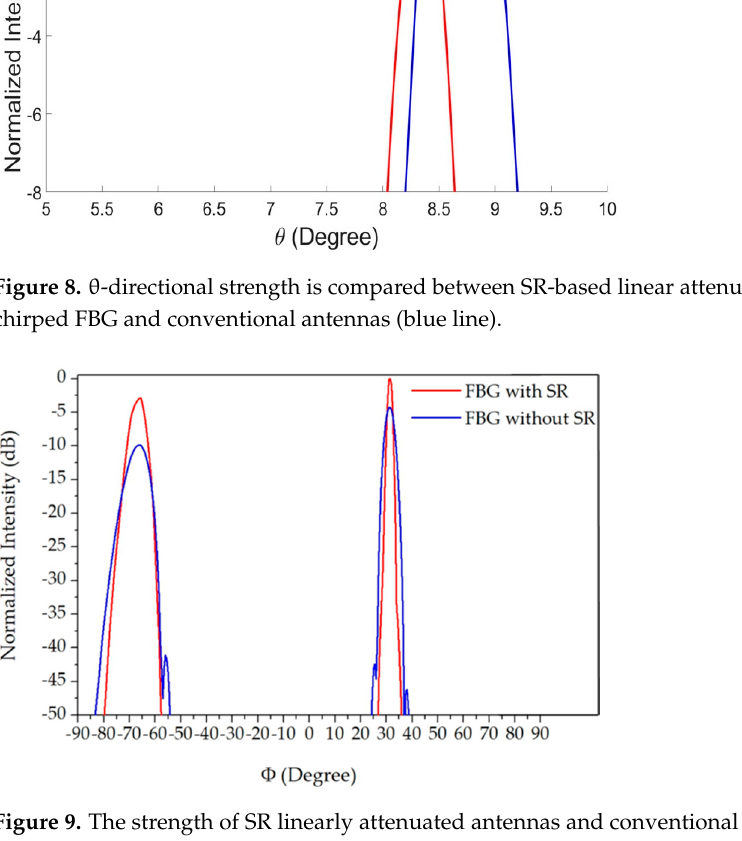
Figure 9. The strength of SR linearly attenuated antennas and conventional antennas are compared in the Φ direction after Δψ = 0.167 π .